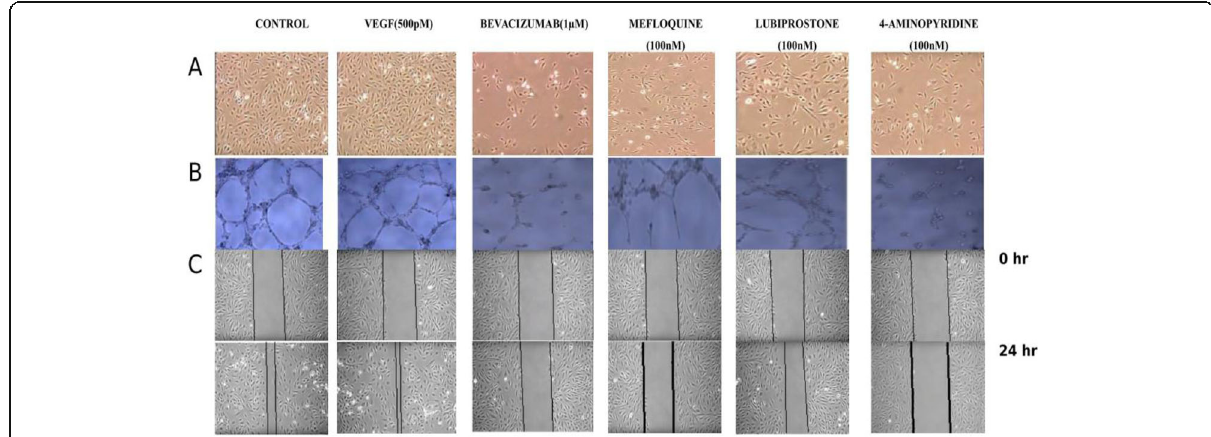
Fig. 3 Endothelial cell response to VEGF, bevacizumab, and ion channel modulators. a Cell proliferation was determined by cell counting with a hemocytometer. b Representative images of tube formation after being treated with ion channel modulators for 2 h following VEGF stimulation. c Quantitative data of migrated cells in HUVECs treated with the standard and test drugs for 24 h under VEGF